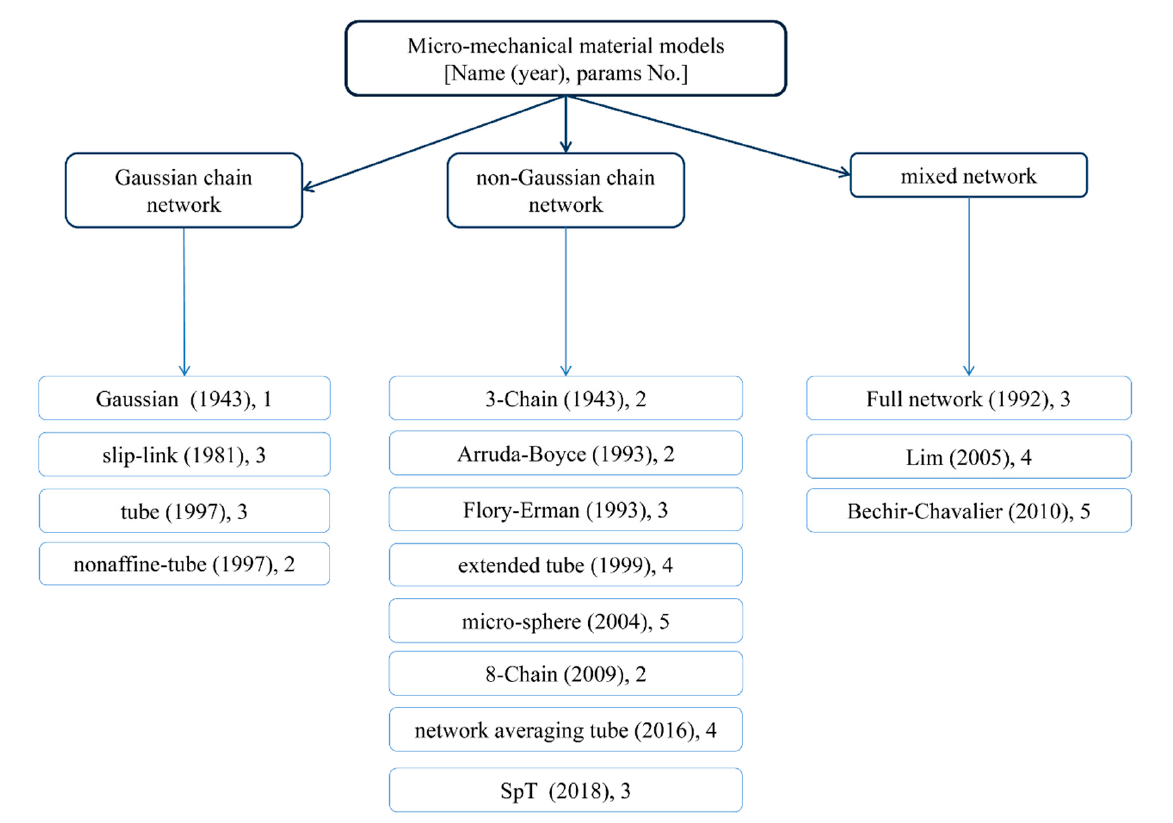
Figure 3. Different micromechanical models of hyper-elastic materials.